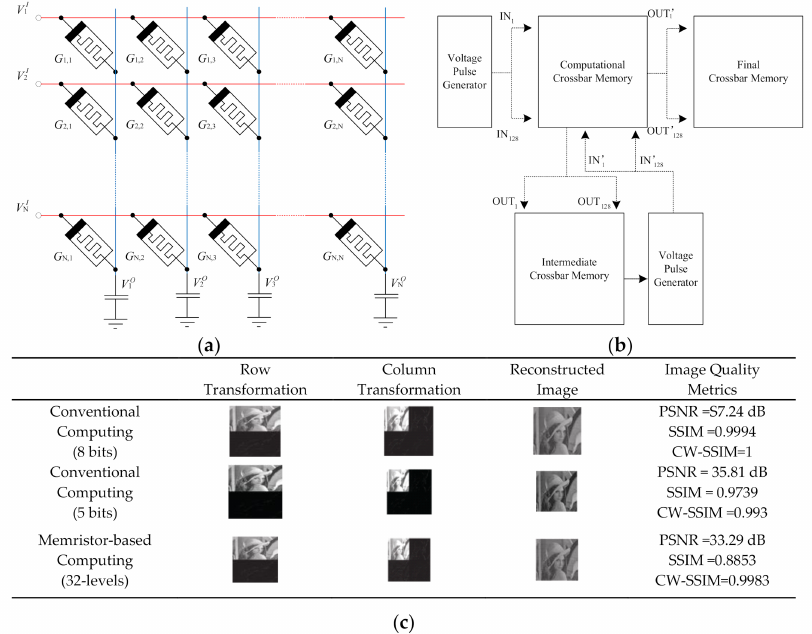
Figure 6. Application of crossbar array based on memristor in image compression. ( a ) memristor crossbar array; ( b ) image compression framework; ( c ) image compression